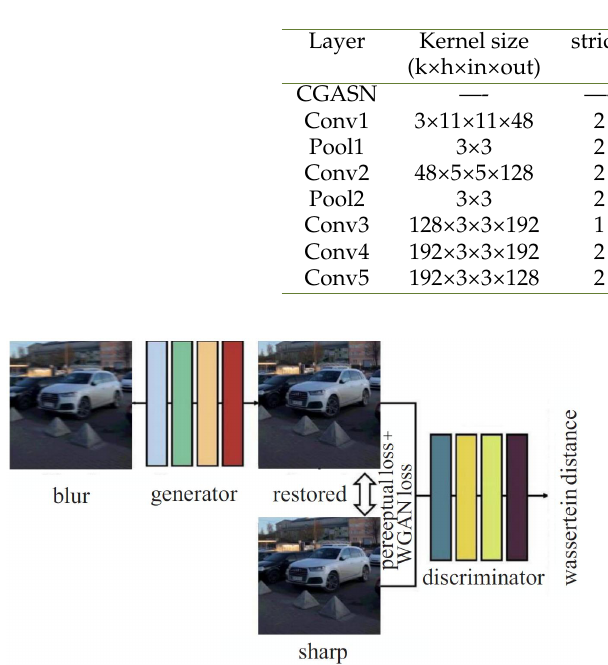
Table 1. Parameter of CGASN.